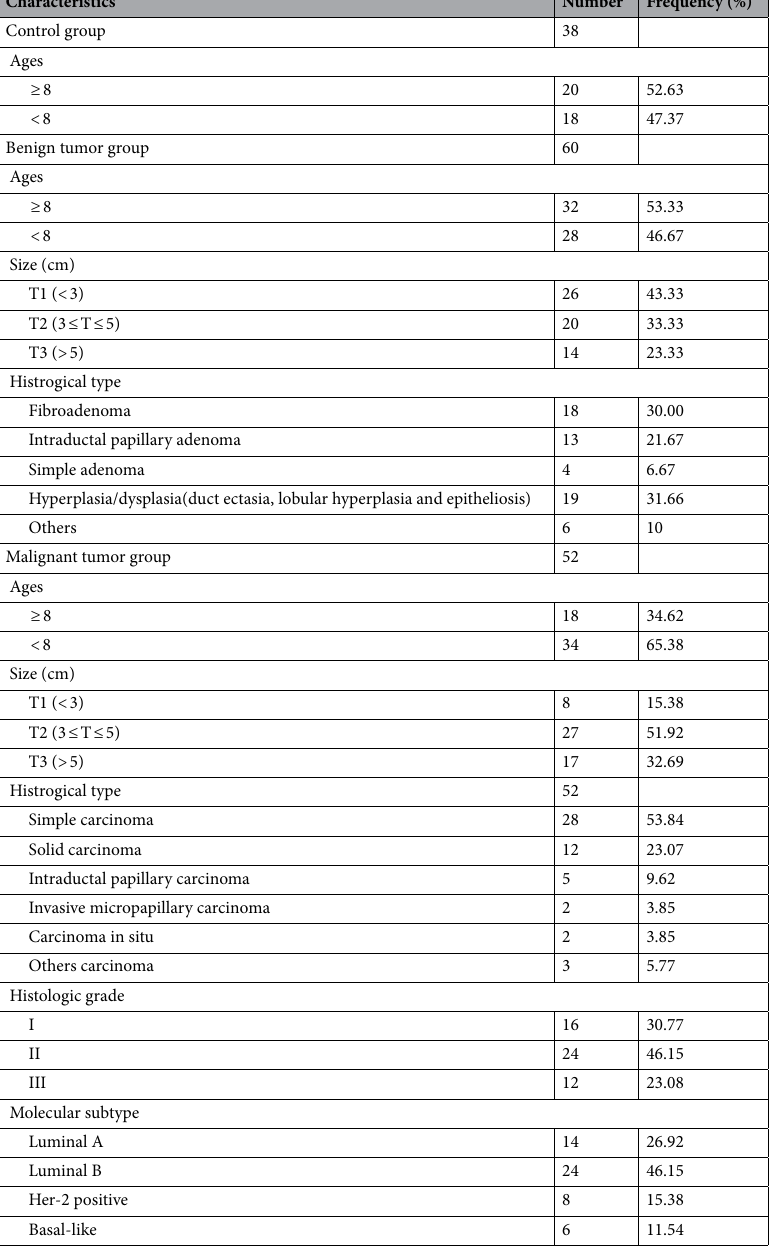
Table 1. General clinical and pathological characteristics of female dogs with